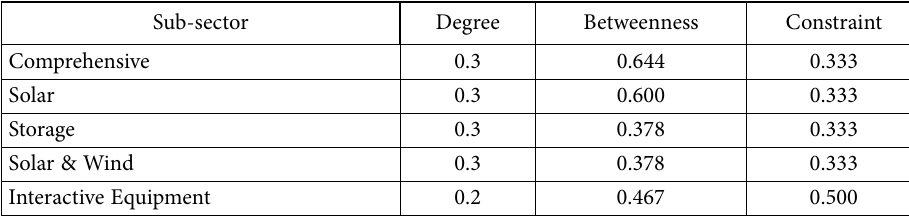
Figure 5. Minimum spanning tree of 11 new energy sub-sector network Table 3. The top 5 influential sub-sectors and topological